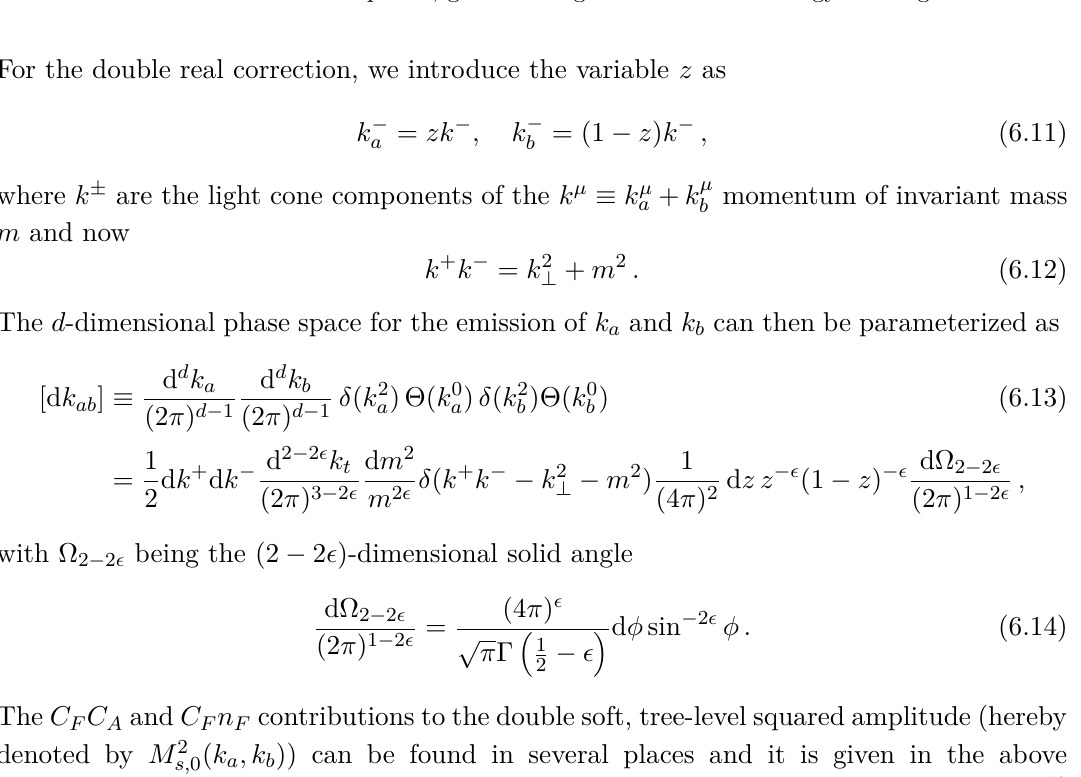
Figure 4 . Diagrams contributing to the non-Abelian part of the two-loop soft function. The gray blobs include the contribution of quarks, gluons and ghosts to the self energy of the